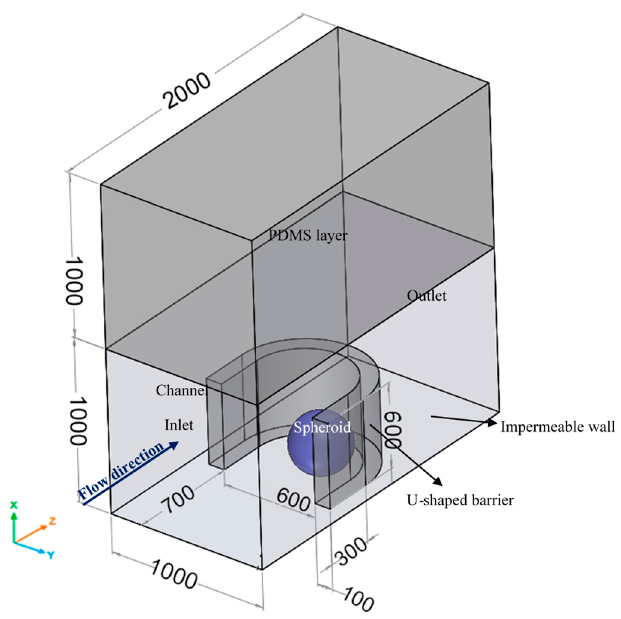
Figure 1. The geometry of an integrated U-shaped microbioreactor used in this study. The system consists of a PDMS U-shaped barrier in a channel with an upper PDMS layer (i.e., the oxygen permeable layer) and a lower glass surface (an oxygen impermeable wall). The spheroid is assumed to be trapped at the boundaries of the U-shaped system. The flow of the culture medium maintains the cellular nutrition and metabolic conditions. All the dimensions are in μ m.